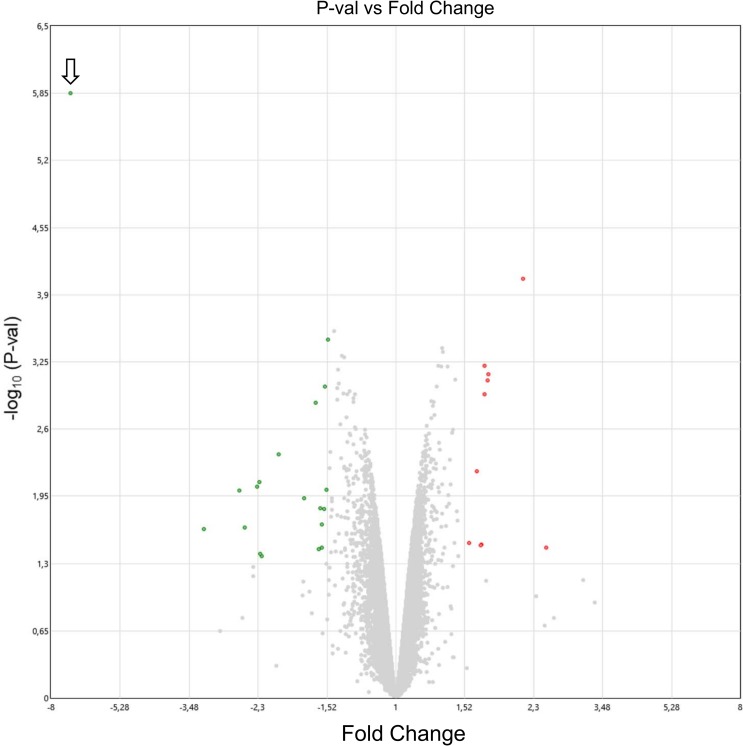
Volcano plot of microarray data.Dots represent the mean expression (n = 2) of individual genes obtained from a microarray normalized dataset. Cut-off values were established according to the following parameters: Fold change = ±1,5 and p-value <0,05. Genes above the cut-off standards are considered as differentially expressed genes and are highlighted as red and green dots, respectively. Genes with fold change above +1,5 are up-regulated in testes of Azin2 KO mice, while genes with fold change below −1,5 are considered as down regulated in testes of Azin2 KO mice. Note the prominent position of the Azin2 gene (arrow), with a fold change value around -7,5. Each sample analyzed was a pool of RNA from three mice. The raw data are available from Gene Expression Omnibus (GEO), accession number GSE121518.